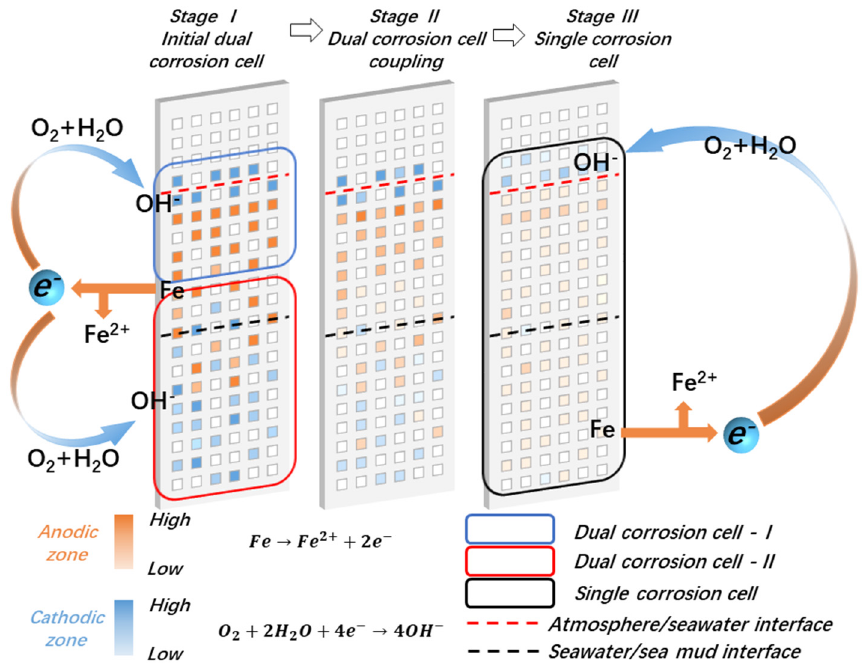
Figure 6. Schematic diagram of metal corrosion processes in sea mud/seawater/atmosphere environment. Stage I: initial dual corrosion cell. Stage II: dual corrosion cell coupling. Stage III: single corrosion cell.